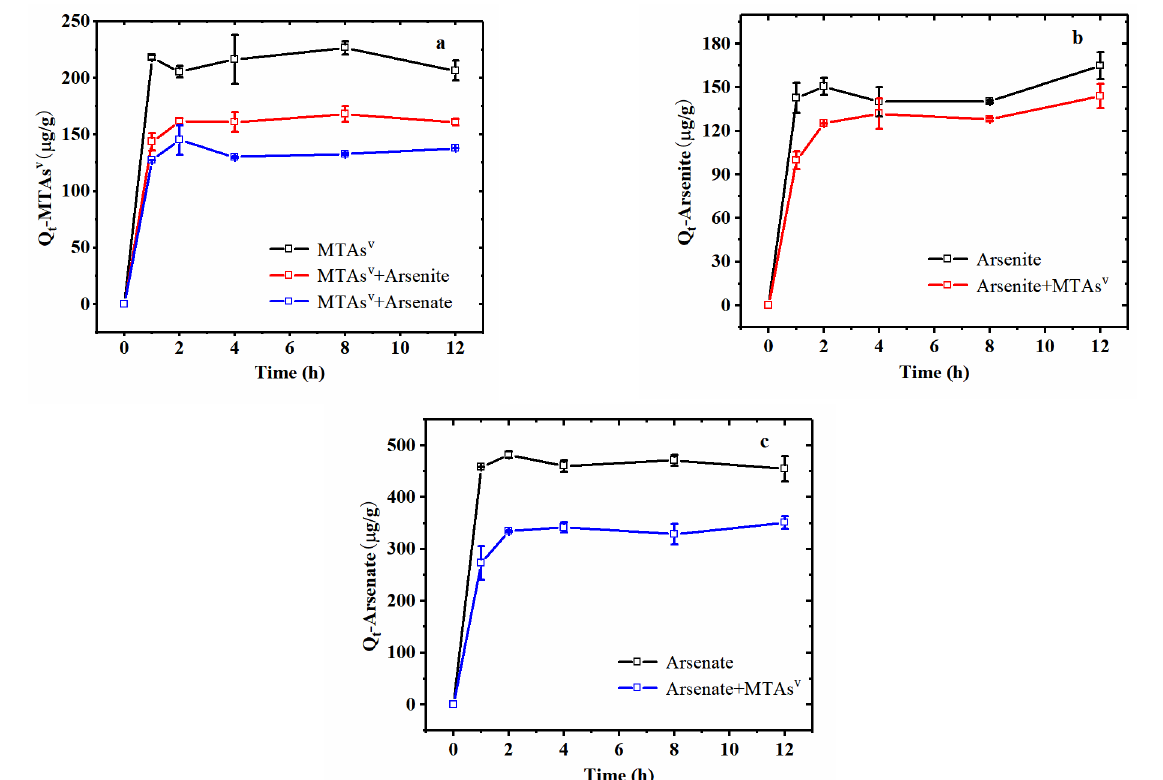
Figure 7. Kinetic adsorption of MTAs V ( a ), arsenite ( b ), and arsenate ( c ) in single ion system and binary ions system, in which the initial concentrations of MTAs V , arsenite, and arsenate are 0.627 mmol/L.